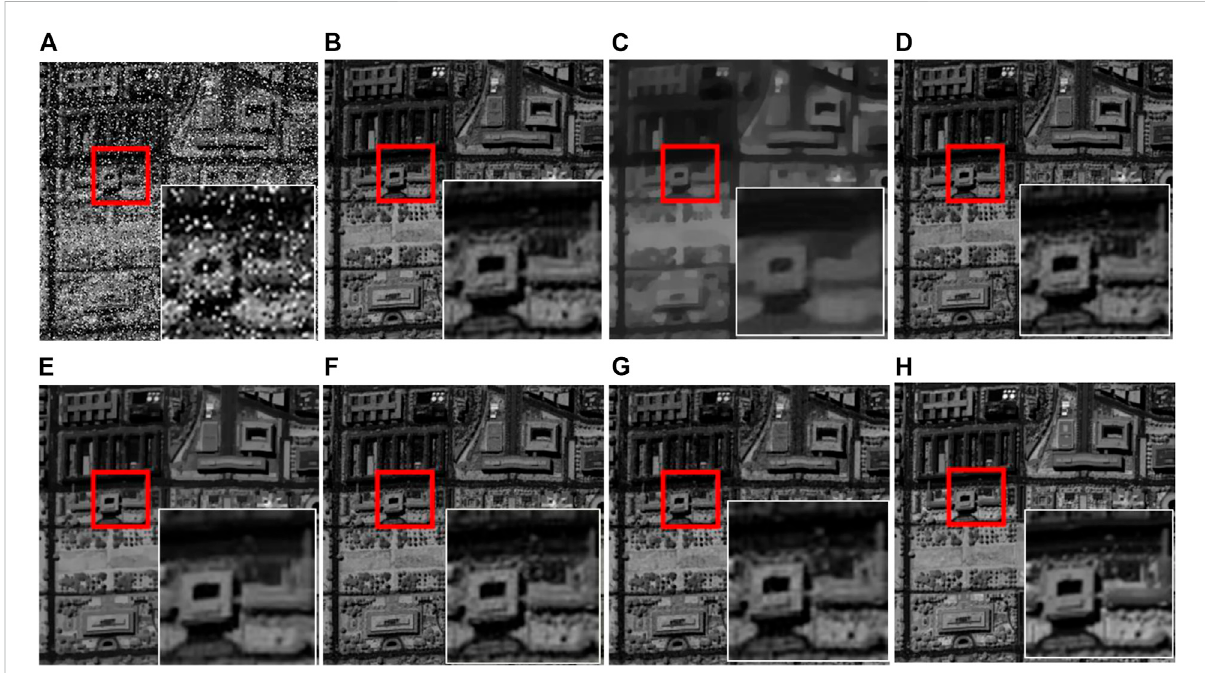
FIGURE 6 Restored results of all comparison methods for band 68 of WDC HSI data under Case 5: (A) Noisy, (B) L 1-2 SSTV, (C) QRNN3D, (D) LRTDGS, (E) SBNTRD, (F) LRTF- L 0 , (G) ANTRRM, (H)